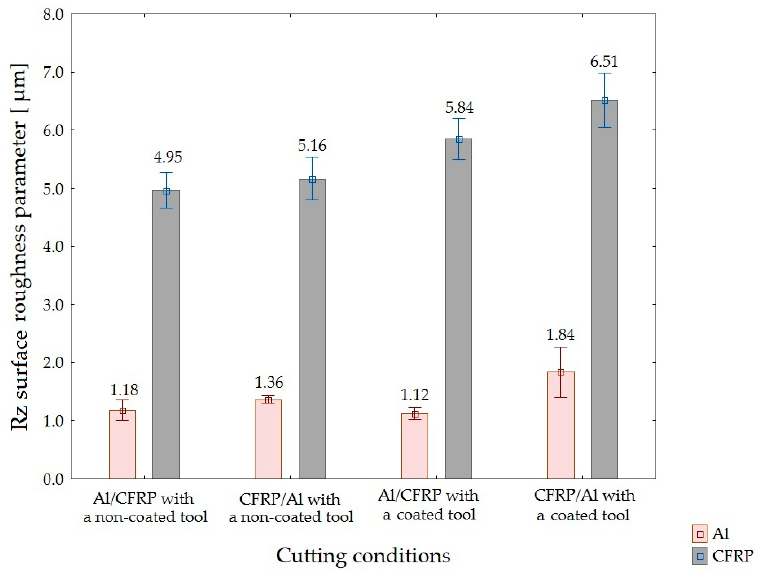
Figure 7. Values of Rz surface roughness parameter depending on the machining configuration and the type of tool.